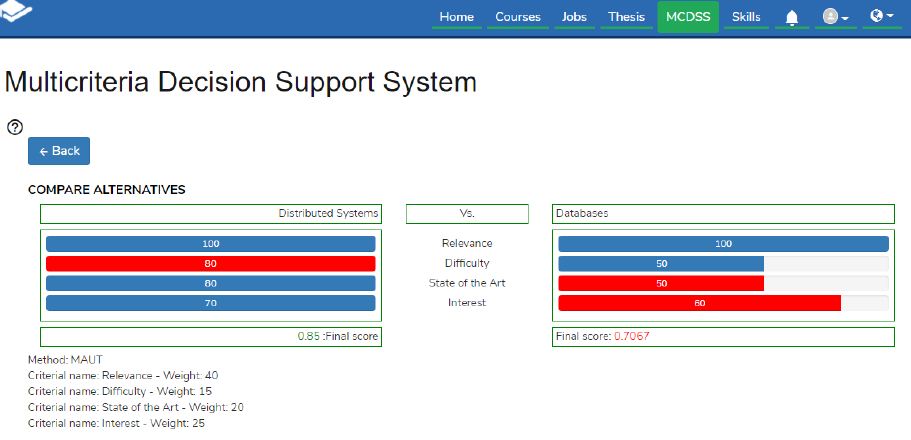
Figure 8. Bipartite comparison between courses.